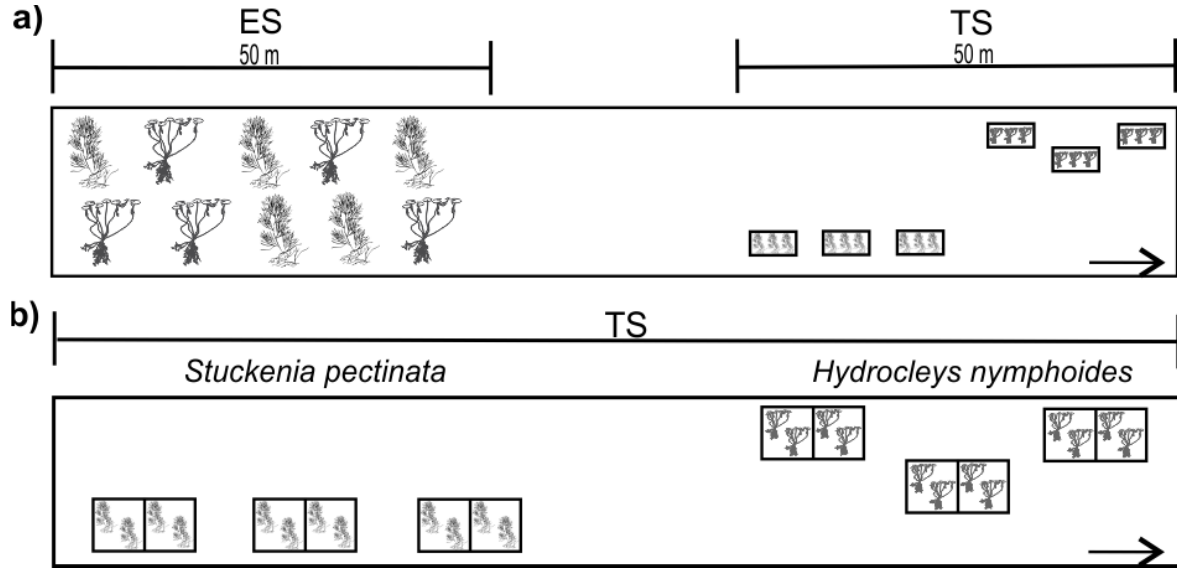
Figure 2. Tray distribution in the stream: a) plan view of tray distribution in the section of Martín Stream showing the extraction site (ES) and transplant site (TS); b) section of the TS magnified with details of the trays’ disposition. The arrows indicate the direction of